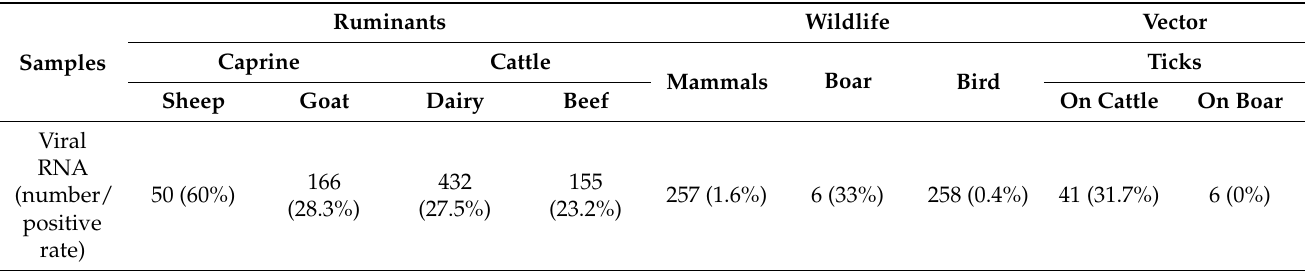
Table 1. Prevalence of SFTS viral RNA on